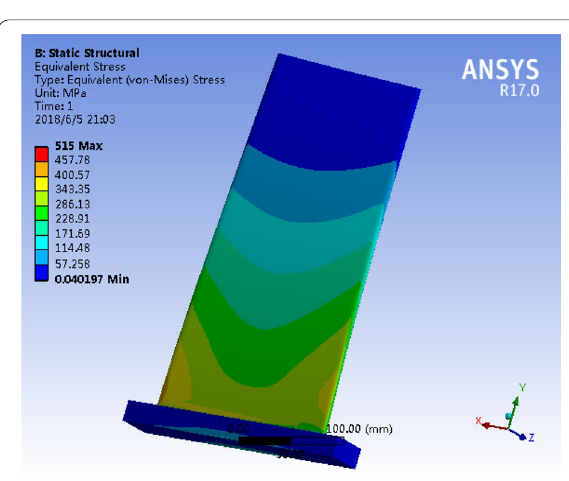
Figure 15 Stress distribution cloud